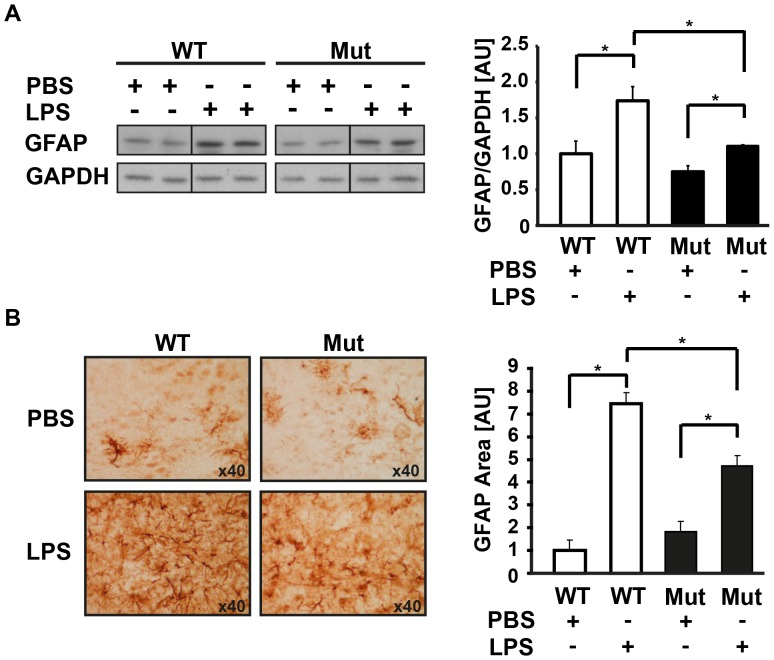
eIF2B5R132H/R132H mice exhibit impaired astrogliosis.Intraperitoneal injections of 5 mg/kg LPS or PBS were administered to 7 Eif2b5R132H/R132H (Mut) and 7 wild-type (WT) mice at P14 and again at P15. At P21 mice were sacrificed and brains were removed. (A) Representative immunoblot analysis of whole brain using anti-GFAP and anti-GAPDH antibodies. Bars represent the average of GFAP/GAPDH from 4 mice per group ± SEM (*p<0.05). (B) Brain slices were analyzed by immunohistochemistry for reactive astrocytes using anti-GFAP antibodies. The total stained area of the thalamus region was quantified and normalised to that of PBS-injected wild-type mice. Representative GFAP positive cells are shown (photographed with ×40 objective). Bars represent the average of 3 mice per group ± SEM (*p<0.0001).